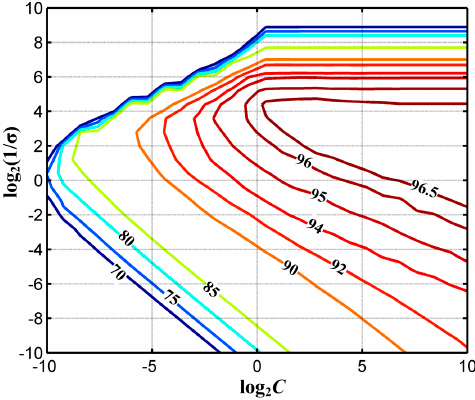
Figure 9. Selection results of SVM parameters.